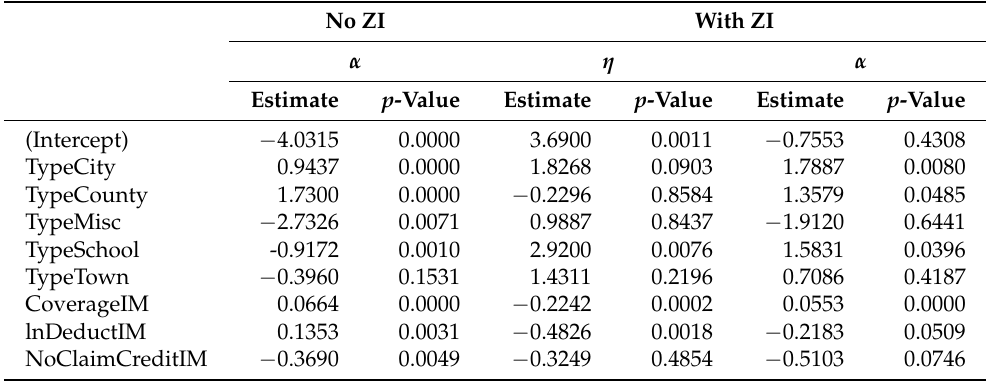
Table 3. Estimation results of the fixed